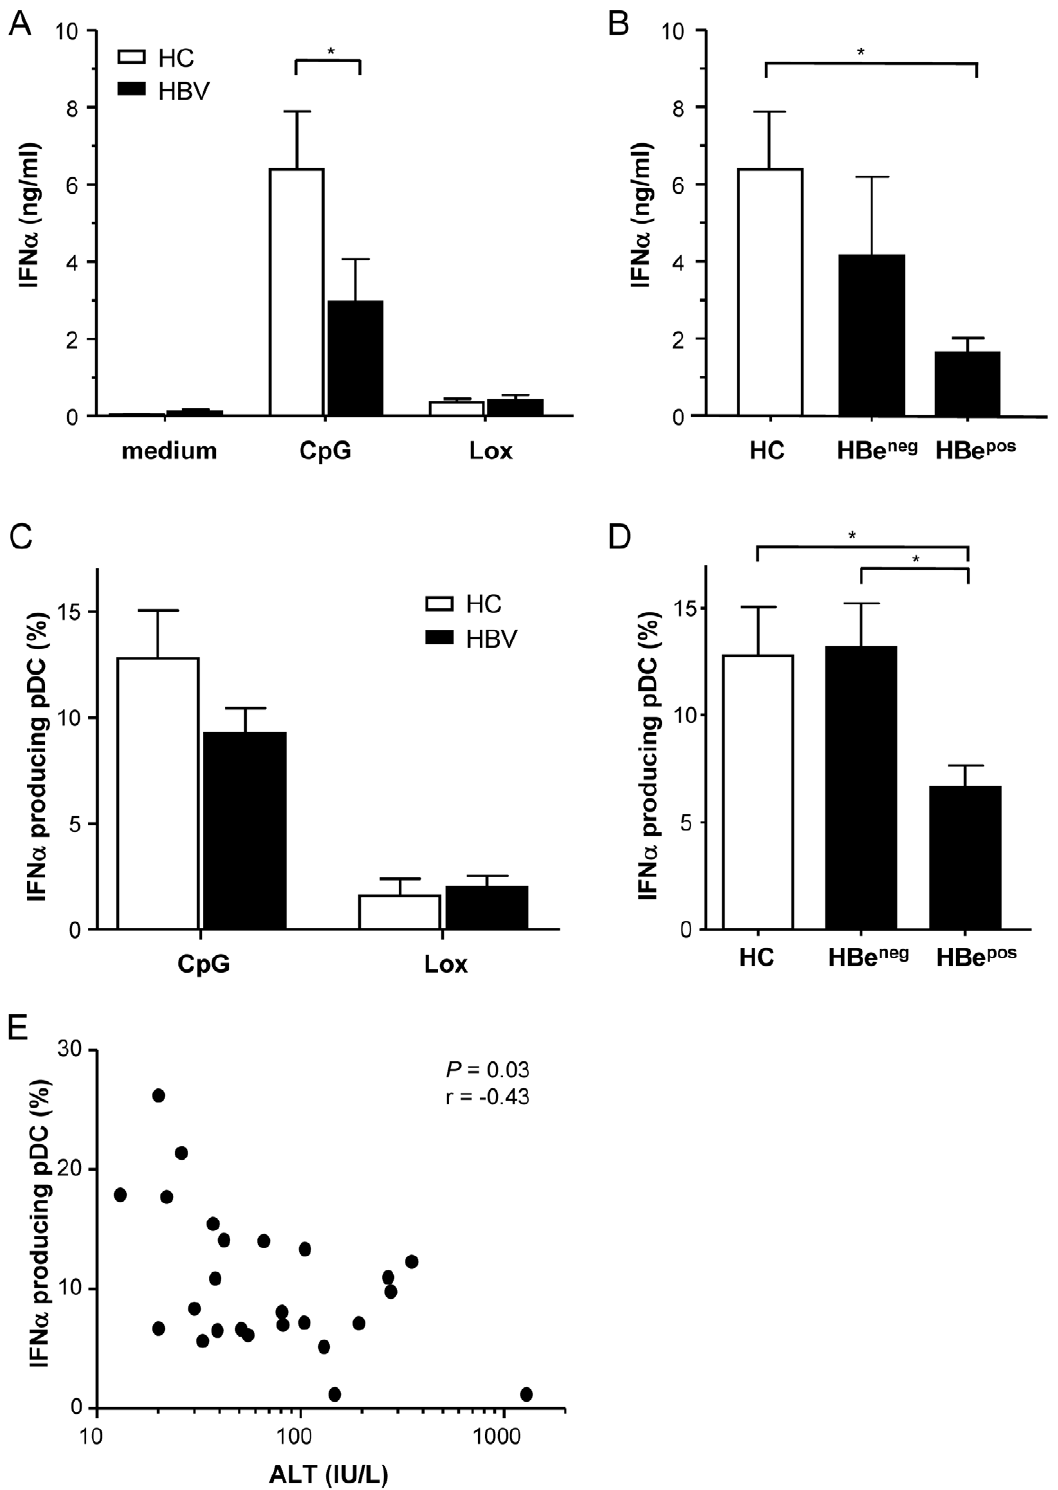
Figure 6. Chronic HBV patients display impaired CpG-induced pDC function. Frozen PBMC from patients (HBV; n=25) and healthy controls (HC; n=21) were thawed, washed and cultured in the absence or presence of CpG or Lox and investigated for the production of IFN a by ELISA (AB) or intracellular flow cytometry (CDE) as described in Materials and Methods . For additional analysis of the CpG-induced IFN a producing capacity, the patient group was divided into HBeAg-positive (n=15) and HBeAg-negative (n=10) disease. Shown are the mean 6 SEM IFN a production by HC and patients (A–D) and the relation between serum ALT levels and IFN a producing pDC within the total patient group as defined by Spearman’s correlation coefficient. *Mann-Whitney U test, P , 0.05.